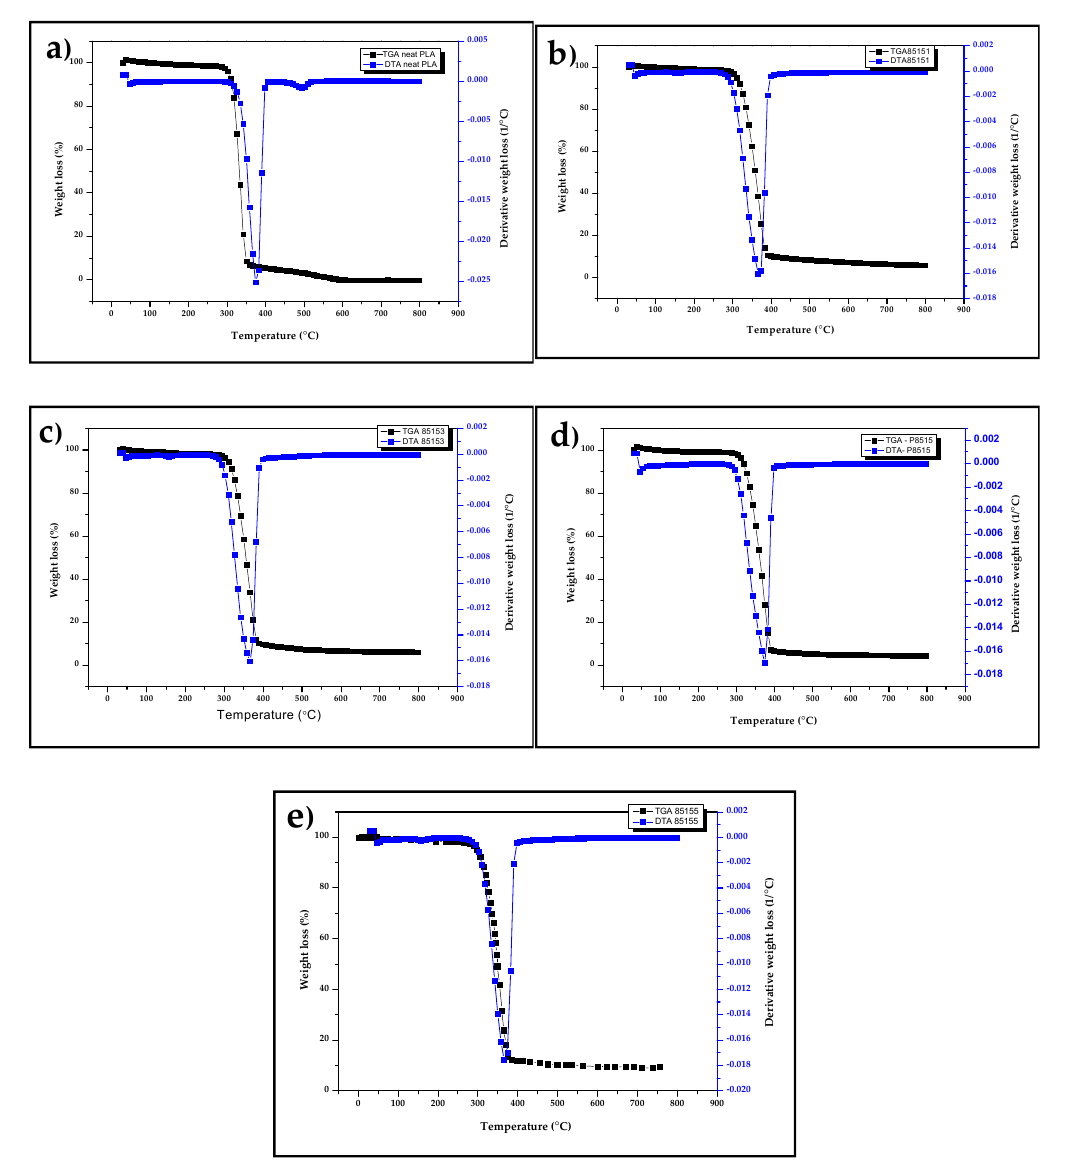
Figure 4. Thermogravimetry analysis (TGA) and derivative thermogravimetric (DTG) for ( a ) neat PLA, ( b ) P8515, ( c ) P85151, ( d ) P85153, and ( e ) P85155 biocomposites.